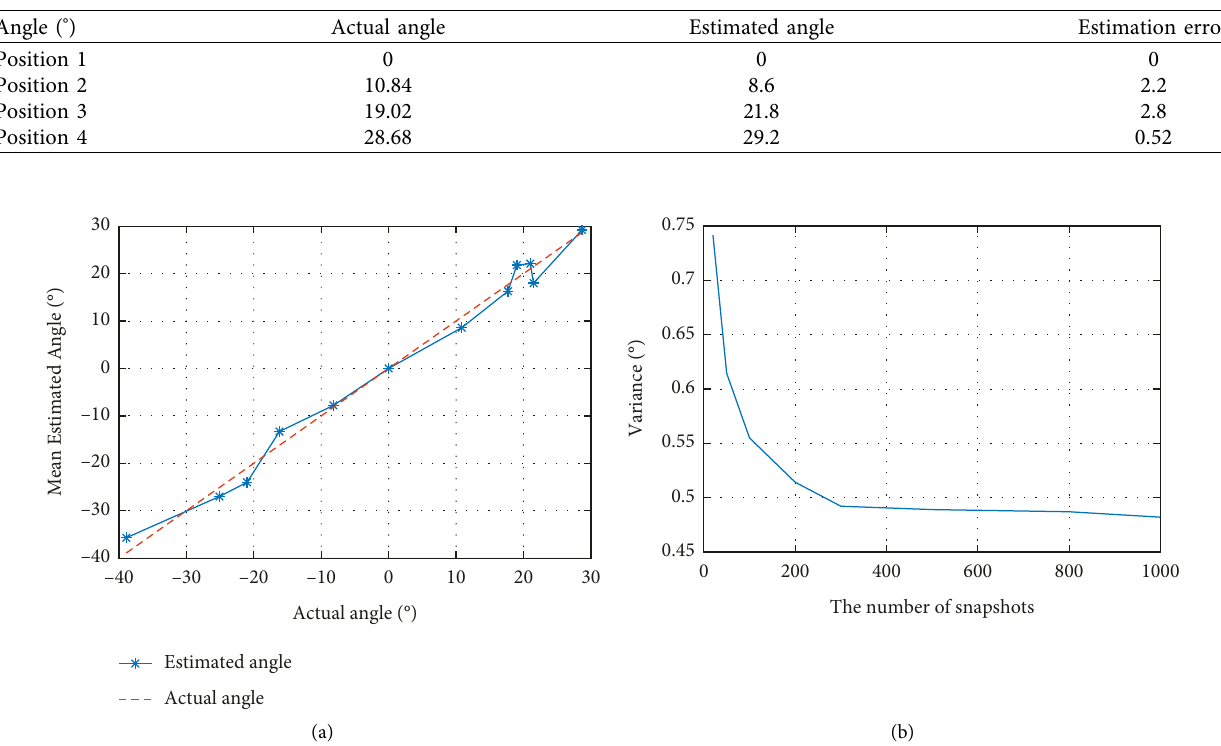
Figure 15: MUSIC spatial spectrum. Table 2: The results of DOA